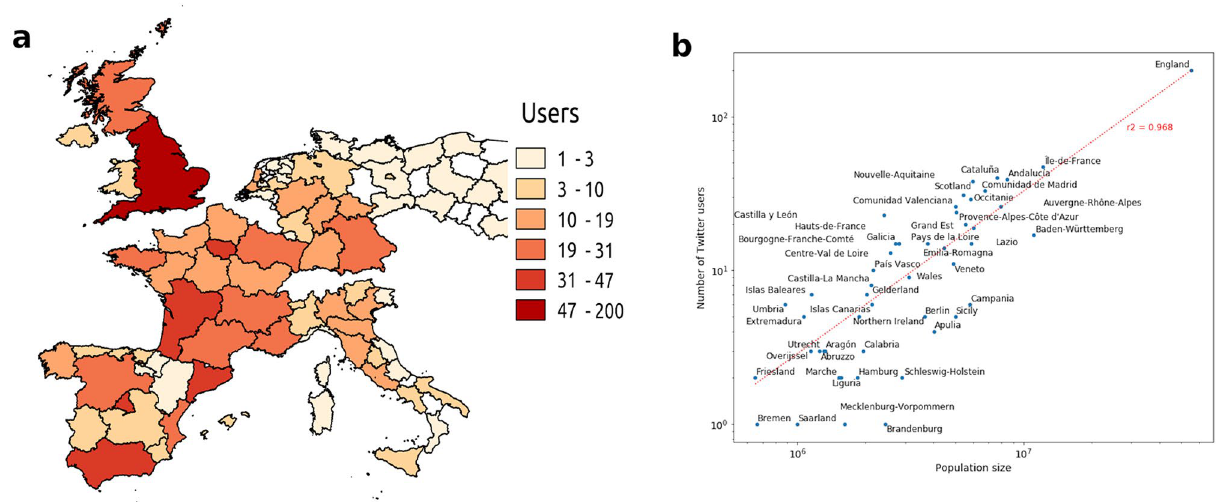
Figure 4. Geo-localization of tweets concerned with Coronavirus posted across Europe and relationship between number of users and population size. ( a ) Geographic distribution of unique users discussing Coronavirus in the winter season between 1 December 2019 and 30 January 2020. The map was generated using the open- source software QGIS 3.10 LTS (https ://qgis.org/it/site/). ( b ) Scatter plot of the relationship between population size of European regions and number of unique users discussing Coronavirus in the same 2019–2020 winter season on a log–log scale. Coefficient of determination R 2 for the linear regression model shows a goodness of fit equal to 0.968. Data on population size was obtained from the official COVID-19 data set (source: John Hopkins University; https ://githu b.com/CSSEG ISand Data/COVID